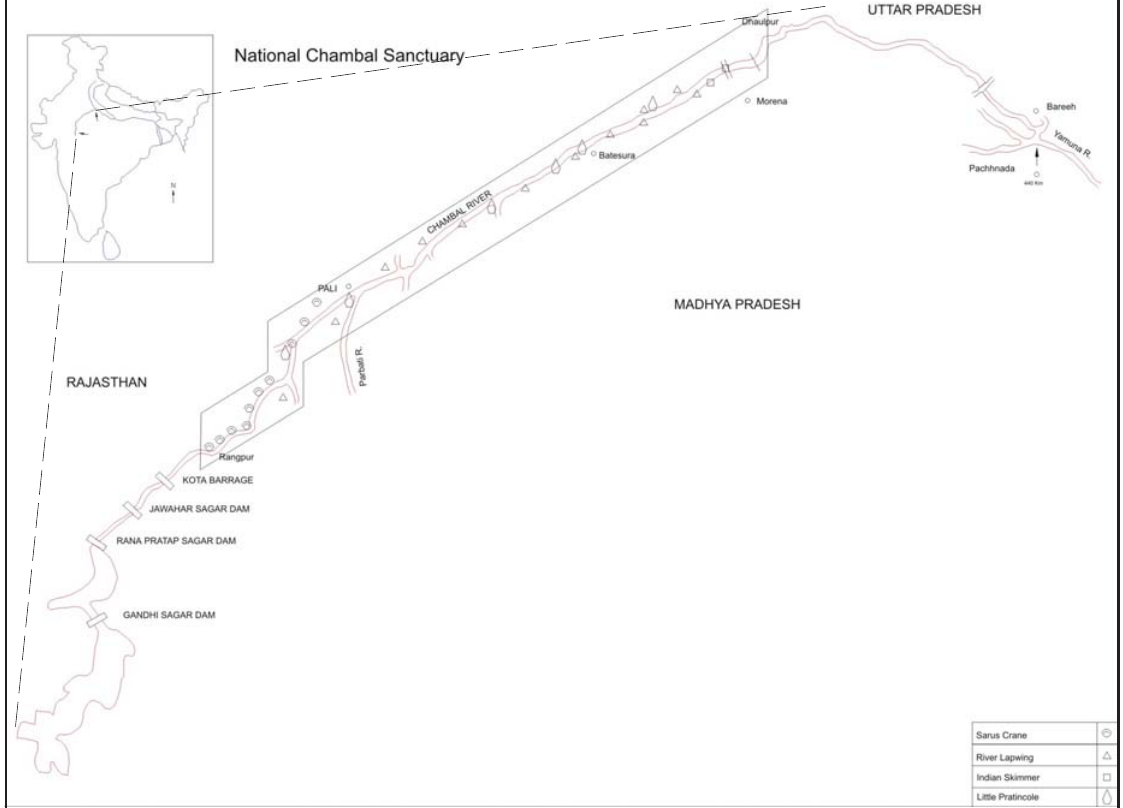
Figure 2. Sighting of some important birds during the 1998